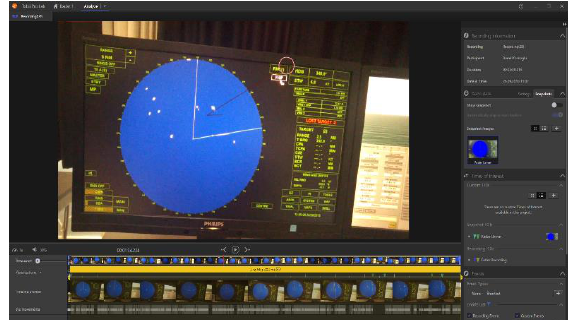
Figure 1. A screenshot of a participant’s recording.